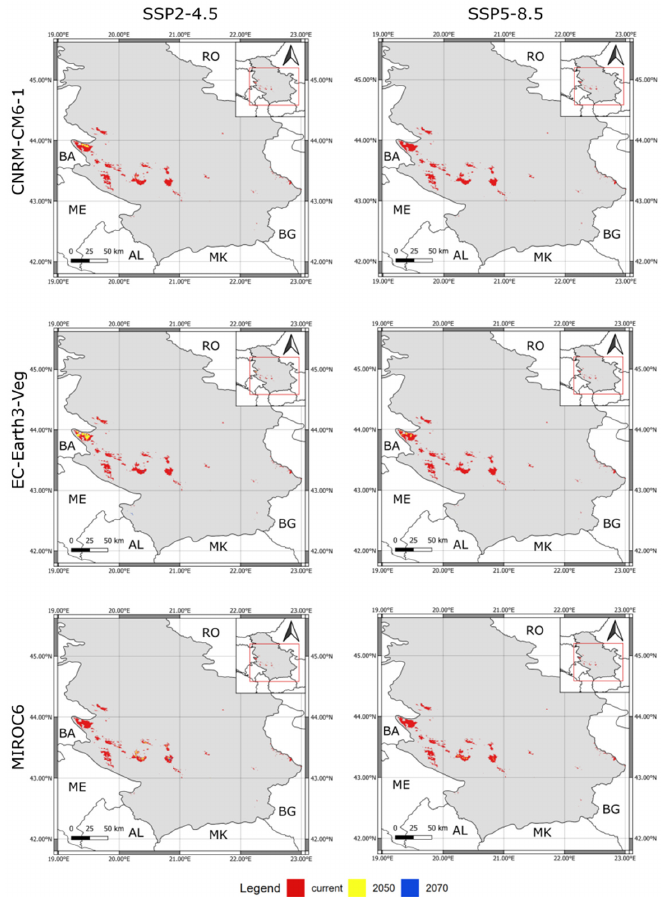
Figure 3. Reduction of predicted suitable range, under each GCM and SSP scenarios, for two reference periods (the 2050s and 2070s). The red color represents a current potential distribution of the species, while the colors yellow and blue represent the species’ predicted range in the years 2050 and 2070, respectively. Map insets show the relative position of the suitable area in Serbia. Country’s abbreviations (RO – Romania; BG – Bulgaria; MK – North Macedonia; AL – Albania; ME – Montenegro; BA – Bosnia & Herzegovina).